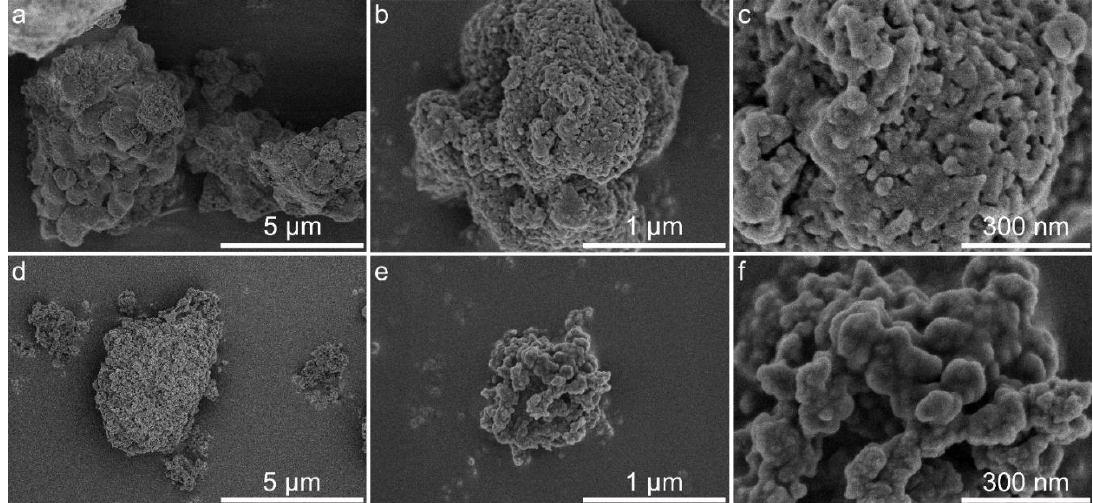
Figure 6. SEM images of the original LignoBoost lignin ( a – c ) and the LignoBoost lignin – silica hybrid ( d – f ) (high-resolution topographic contrast secondary electron imaging, parameters: accelerating voltage = 1 kV; working distance: ( a – c ) 1.4 mm, ( d – f ) 1.8 mm; magnification: ( a , d ) ×10,000, ( b , e ) ×50,000, ( c , f ) ×150,000).